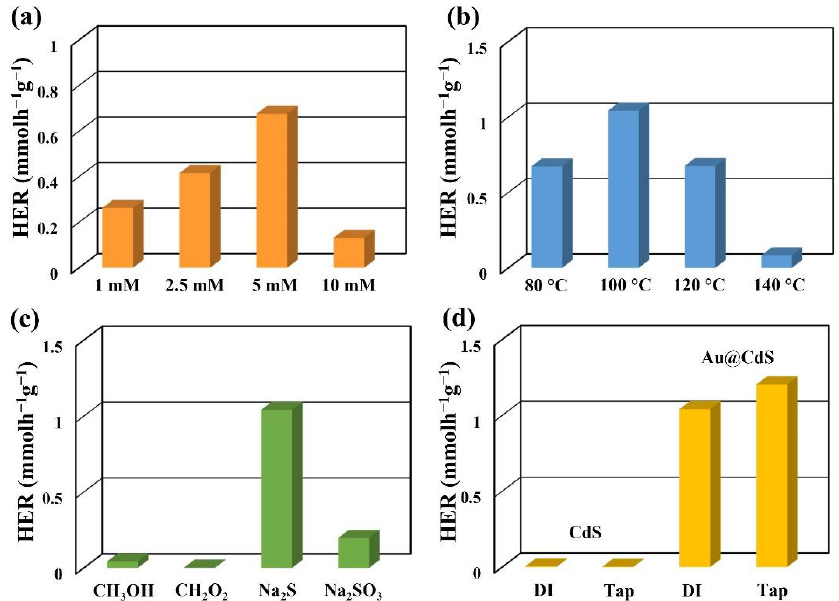
Figure 7. The average HER of Au@CdS nanocomposites grown at different ( a ) CdS precursor concentrations and ( b ) reaction temperatures. ( c ) The average HER of Au@CdS nanocomposites at different sacrificial reagents. ( d ) The average HER of CdS NPs and Au@CdS nanocomposites for de-ionized or tap water.